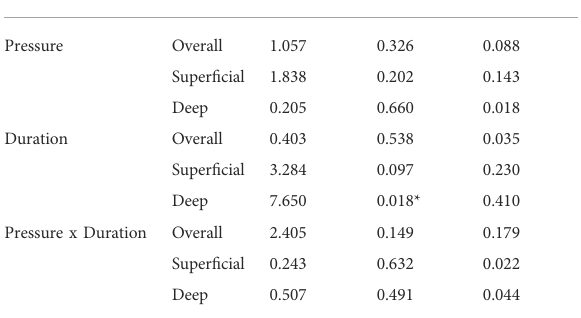
FIGURE 3 Comparisons of overall stiffness of the triceps muscle after cupping therapy at 225 and 300 mmHg for 5 and 10 min. Three of four cupping protocols have lower post-cupping stiffness compared to pre-cupping stiffness, except cupping therapy at 225 mmHg for 10 min.